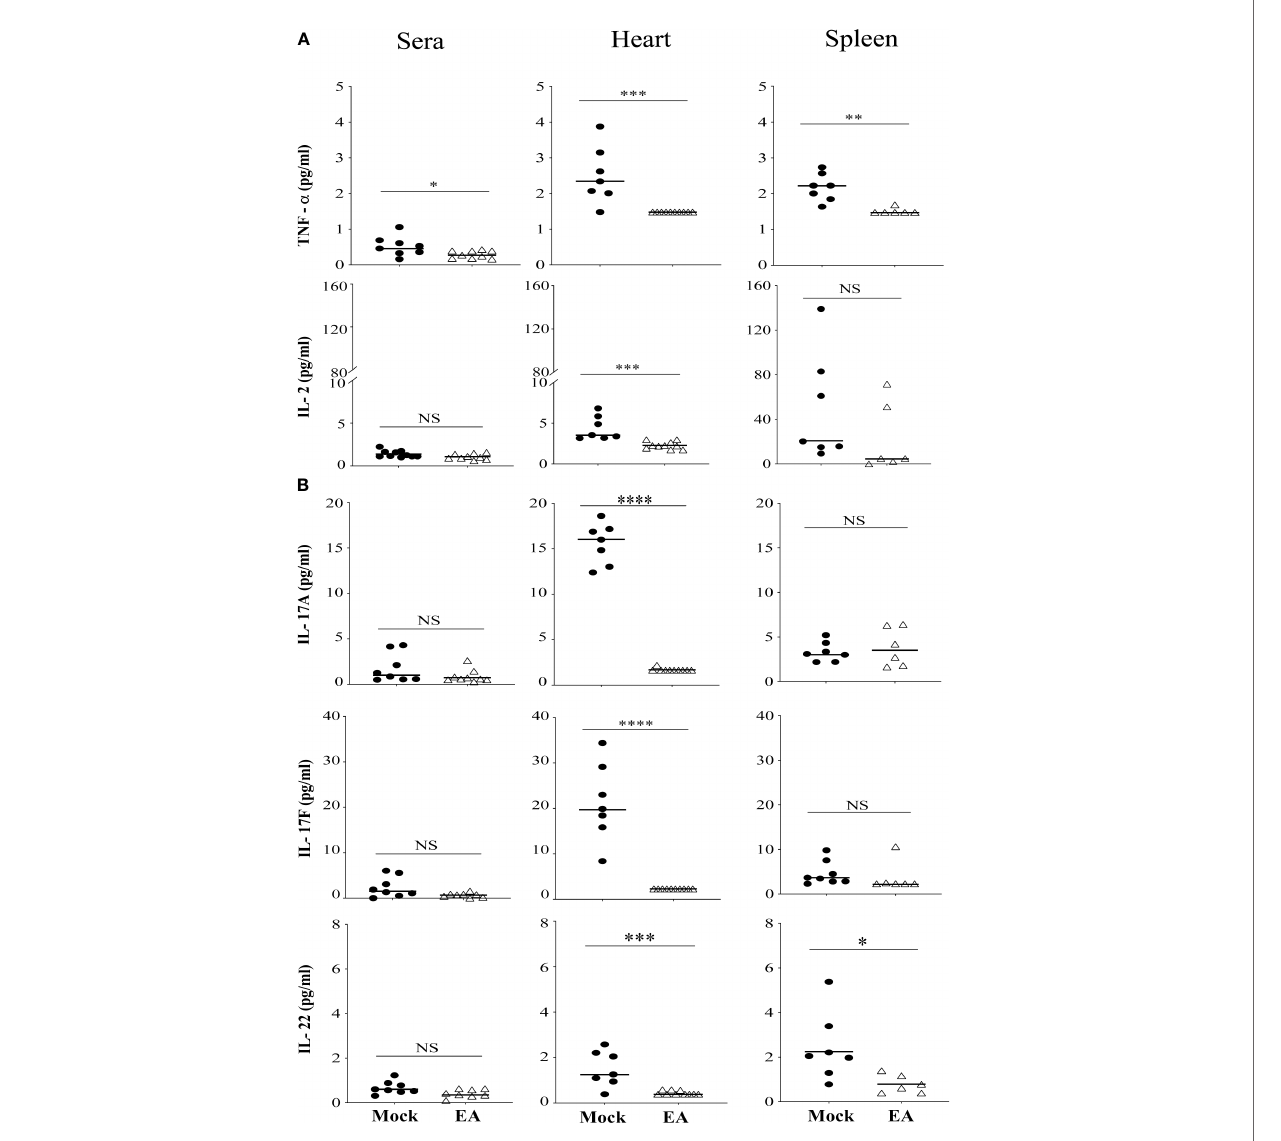
FIGURE 4 | Systemic effect of EA on proin fl ammatory cytokines levels in serum and extracts from heart and spleen of Borrelia burgdorferi -infected C3H/HeJ male mice. (A) Proin fl ammatory cytokine TNF- a reduced signi fi cantly after EA treatment in serum, and heart and spleen extracts, while IL-2 reduced signi fi cantly only in heart and not spleen extracts or serum. (B) IL-17A, IL-17F, and IL-22 cytokines produced mostly by Th17 cells were reduced signi fi cantly in heart in EA-treated mice at 4 weeks post-infection (p.i.), while spleen also showed signi fi cant reduction in IL-22 levels. Bars indicate median values. Statistical analysis was conducted using two-tailed unpaired Student ’ s t-tests for unequal variance to determine signi fi cant differences between the paired groups (NS, not signi fi cant; *p < 0.05, **p < 0.01, ***p < 0.001, ****p <